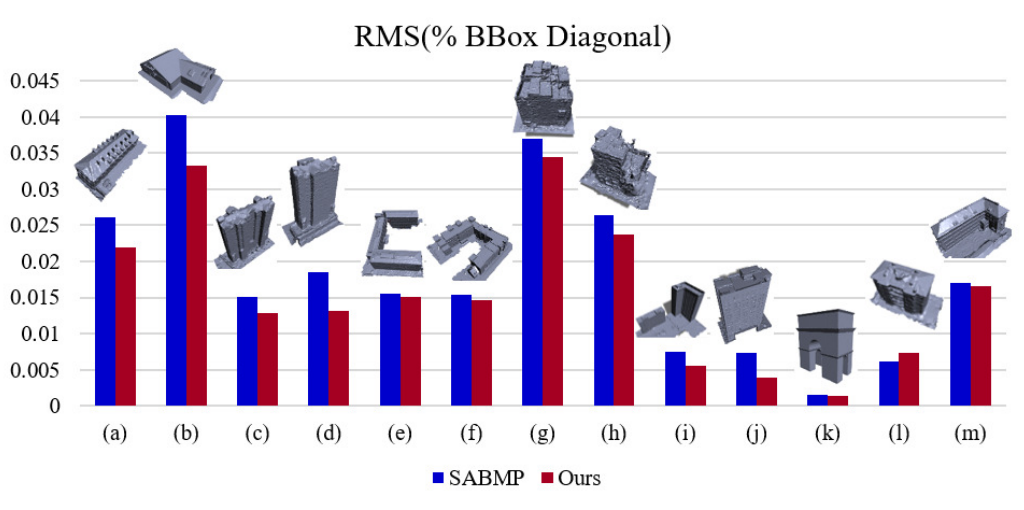
Figure 18. Comparison with SABMP [11] of RMS values. ( a – m ) respectively represent different building models in the quantitative assessment